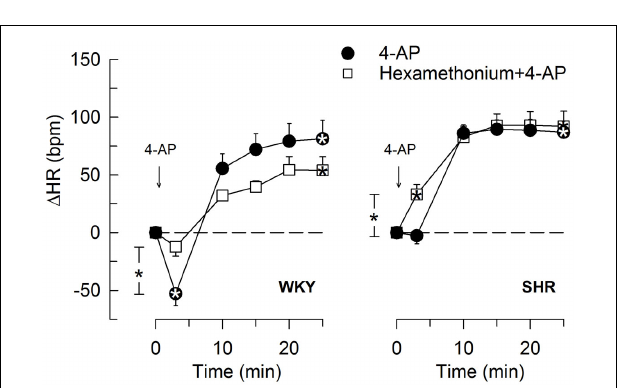
FIGURE 2 |The HR- andTPVR-response to 4-AP inWKY and SHR after pre-treatment with other K + channel inhibitors. Rats were pre-treated with the BK Ca inhibitorTEA or the K ATP channel inhibitor glibenclamide as indicated by symbol legend. Significant responses